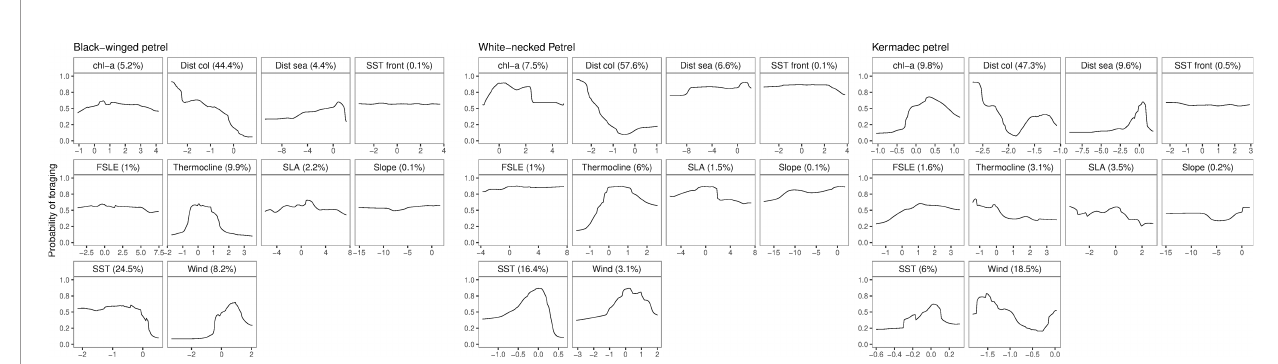
FIGURE 7 | Response curves of scaled predictors and associated predictor importance in the spatially independent cross-validation ensemble models of black- winged (left), white-necked (center) and Kermadec (right) petrel foraging preferences. Predictor variables include chlorophyll a concentration (chl- a ), distance from the colony (Dist col), distance from seamounts (Dist sea), sea-surface temperature fronts (SST front), Finite-sized Lyapunov Exponent (FSLE), thermocline depth (Thermocline), sea level anomaly (SLA), bathymetric slope (Slope), sea-surface temperature (SST) and wind